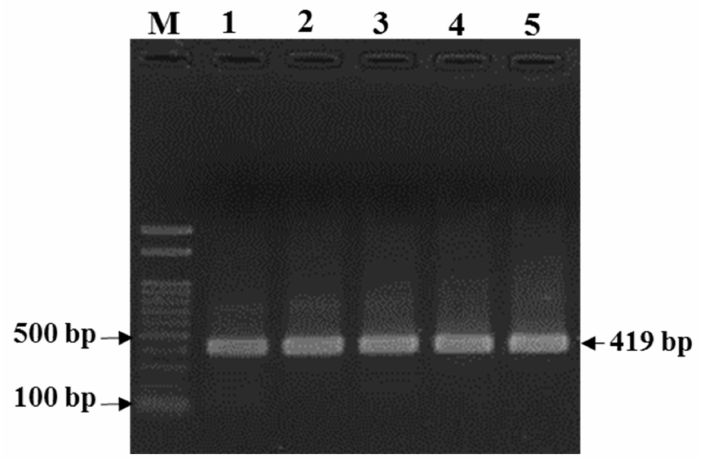
Figure 2. PCR amplification of Rhipicephalus ( Boophilus ) decoloratus partial octopamine/tyramine receptor gene. Lane M, 100 bp marker; Lane 1, R. ( B .) microplus Thailand strain (control DNA); Lanes 2–5, R. ( B .) decoloratus DNA samples from different farms/populations from Uganda: 2, 1SHM; 3, 2BUS; 4, WKB; 5,